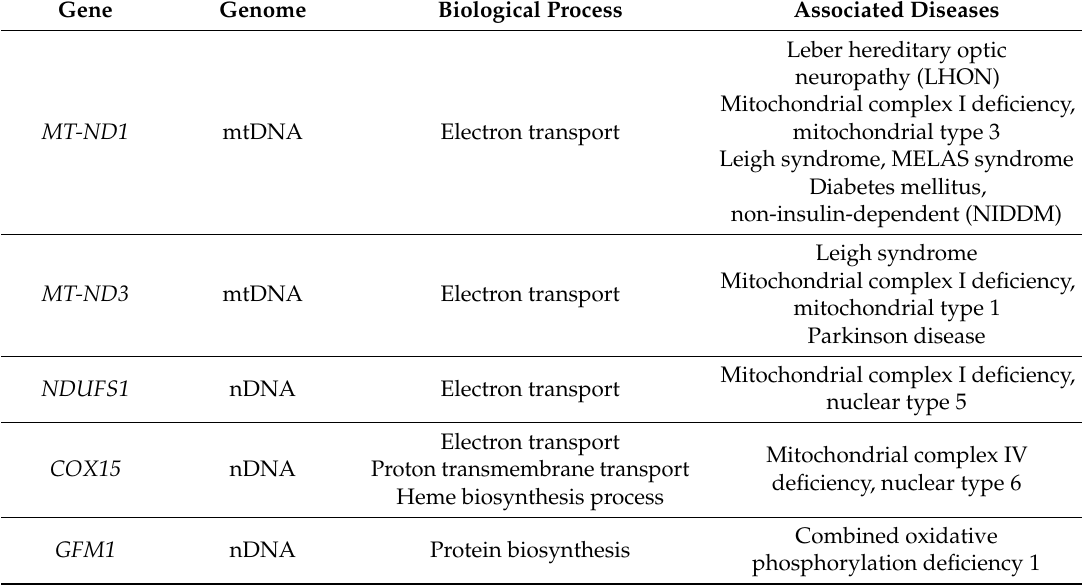
Table 2. Genes implicated in mitochondrial diseases. Mitochondrial and nuclear DNA mutation-causing inherited mitochondrial disorders. The table presents the mutations that are under study in the Mitocure platform. mtDNA, mitochondrial DNA; nDNA, nuclear